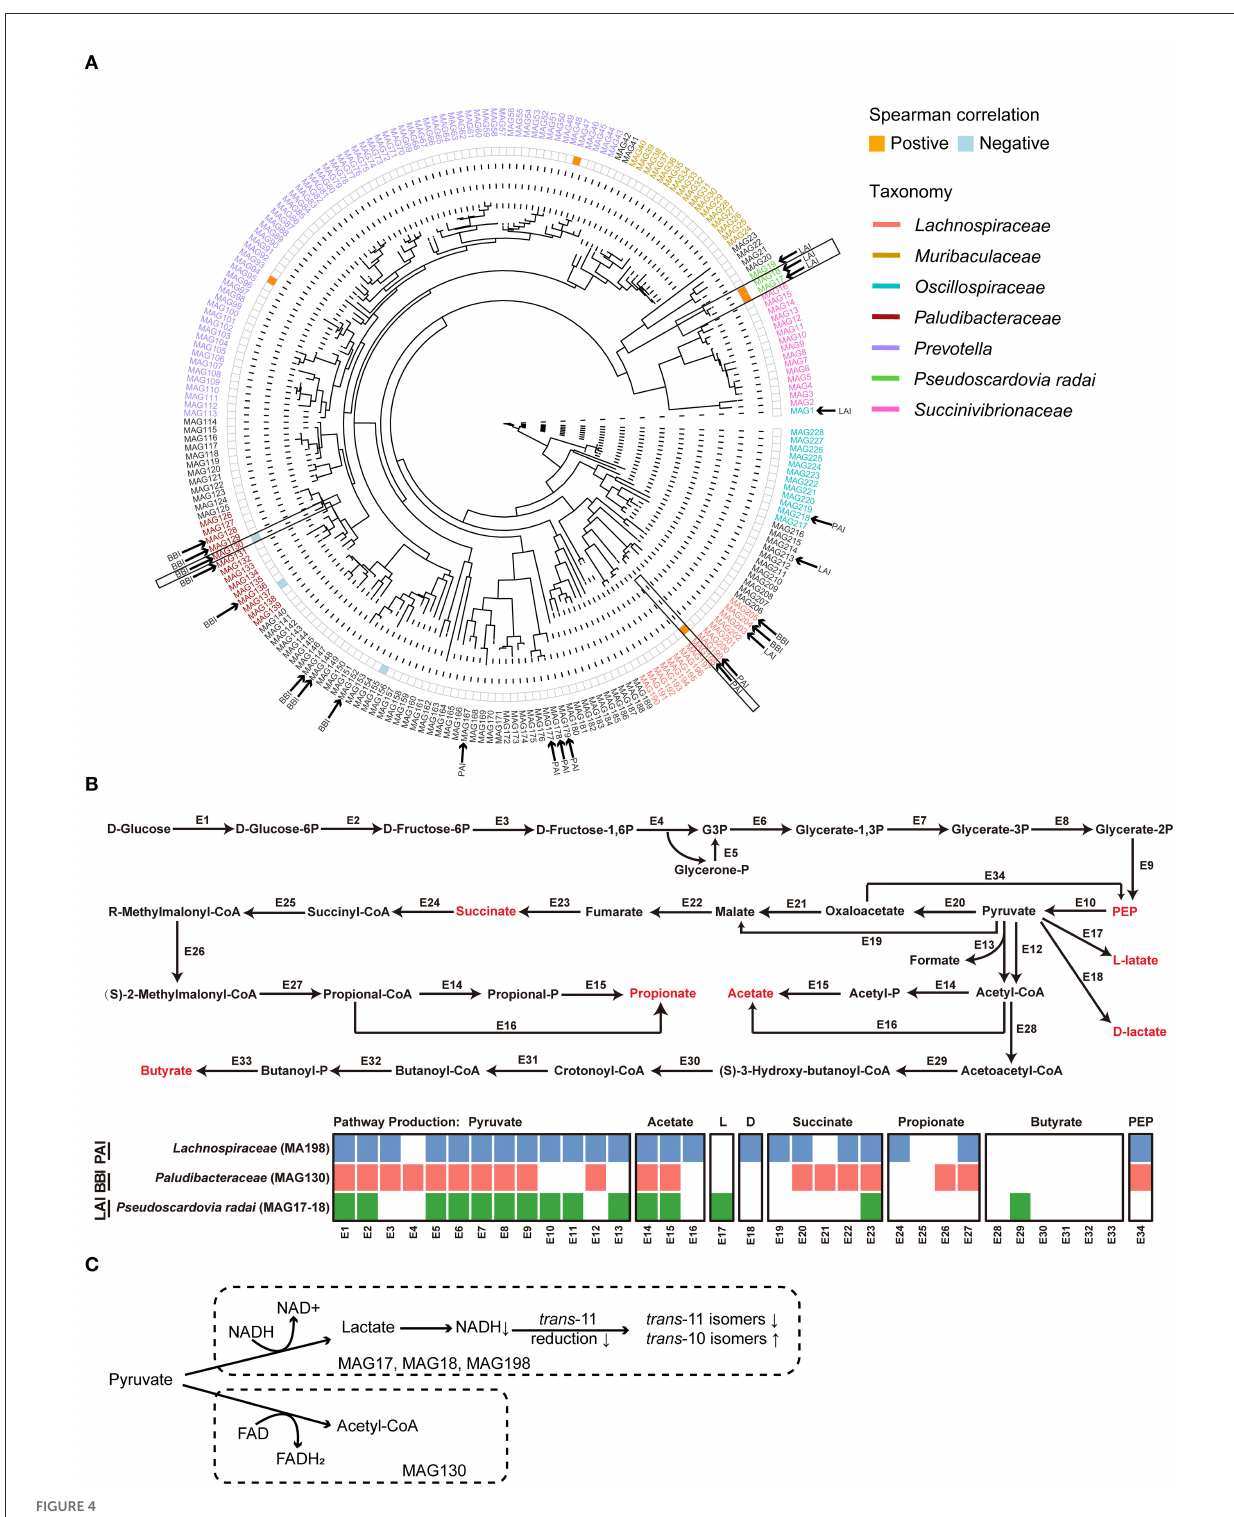
FIGURE4 (A) The phylogenetic tree of 228 metagenome-assembled genomes (MAGs). The color orange and blue on the heatmap next to the tree represented significantly positive correlations and negative correlations between the relative abundance of MAGs and the relative content of milk trans- 10 , cis- 12 C18:2, respectively. The MAGs who contained the linoleic acid (LA) isomerase were marked by the black arrow. The MAGs in black frame were selected to do the genomic analysis. (B) The glucose metabolism pathways of the selected MAGs. The detailed information of the enzyme genes was listed in Supplementary Table 4. (C) The hypothesis concerning the relationship of the major suppliers of reducing equivalents and the production of C18:2 isomers for the biohydrogenation bacteria in rumen. HF, the top 10 cows with the highest milk fat percentage; LF, the last 10 cows with the lowest milk fat percentage; BBI, Bifidobacterium linoleic acid (LA) isomerase; LAI, Lactobacillus LA isomerase; PAI Propionibacterium LA isomerase; NAD, nicotinamide adenine dinucleotide; FAD, flavin adenine